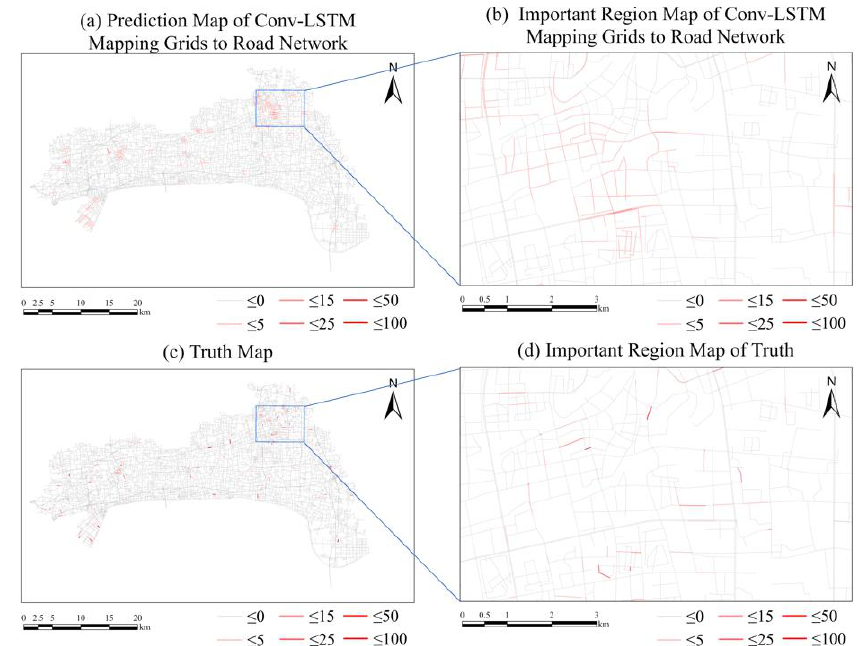
Figure 15. Comparison between the predicted result using Conv-LSTM (mapping the result of grids to the road network) and the truth. ( a ) Predicted result of traffic violations using Conv-LSTM (mapping the result of grids to the road network). ( b ) Important region map of Conv-LSTM. ( c ) Truth values of traffic violations. ( d ) Important region truth values of traffic violations.